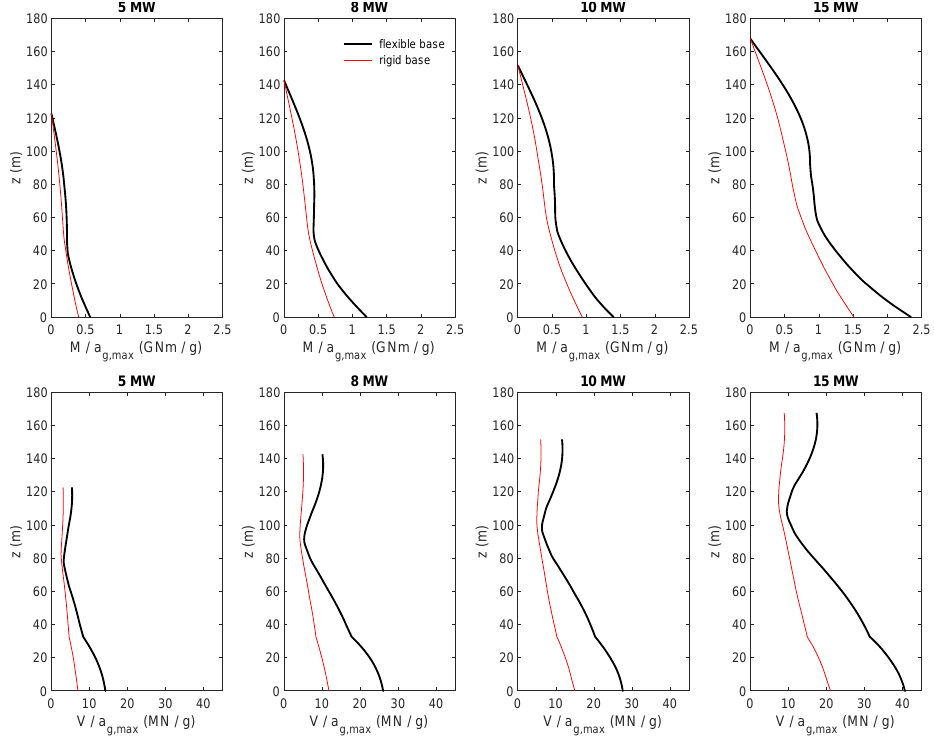
Figure 4. Mean envelopes of maximum seismic internal forces along the superstructure depending on turbine size. v s = 200 m/s. Comparison of the response obtained from the flexible and rigid base